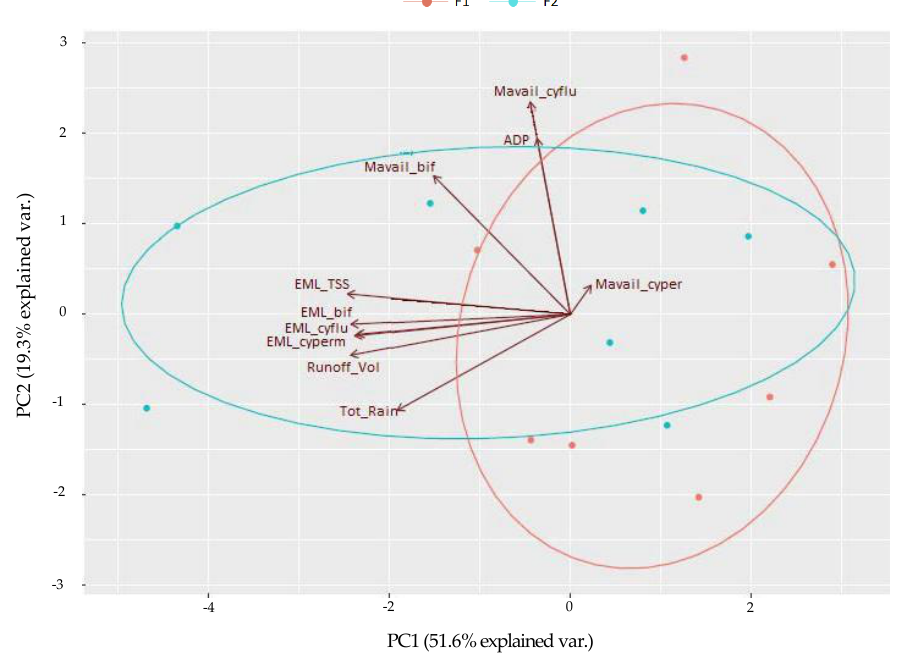
Figure 3. Principal component analysis PCA biplot of F1 and F2 for identifying relationships between rainfall and water quality characteristics.